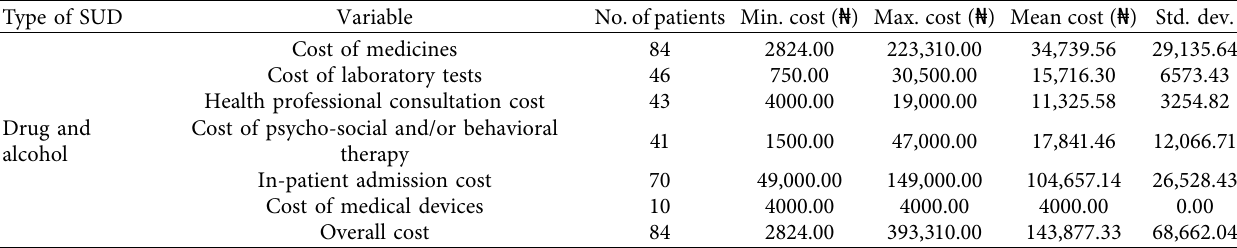
Table 3: Classes and costs of medicines used for the treatment of substance use disorders # . Type of